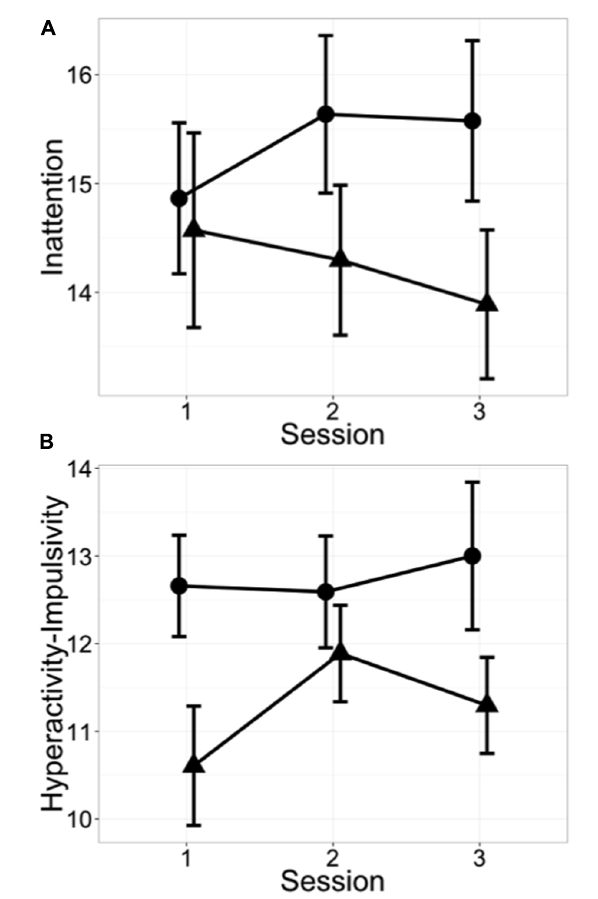
FIGURE 1 | Inattention, but not hyperactivity–impulsivity, was reduced in tai chi students compared to control subjects. (A) ADHD indicators of inattention (ASRS inattention items 1–9) improved in tai chi students relative to controls ( p = 0.044, linear mixed effects model group × session interaction). (B) No significant change was seen in hyperactivity–impulsivity (ASRS hyperactivity–impulsivity items 1–9).Test sessions conducted at (1) beginning, (2) middle, and (3) end of semester. • = control subjects; (cid:2) = tai chi students. Mean ± SEM.